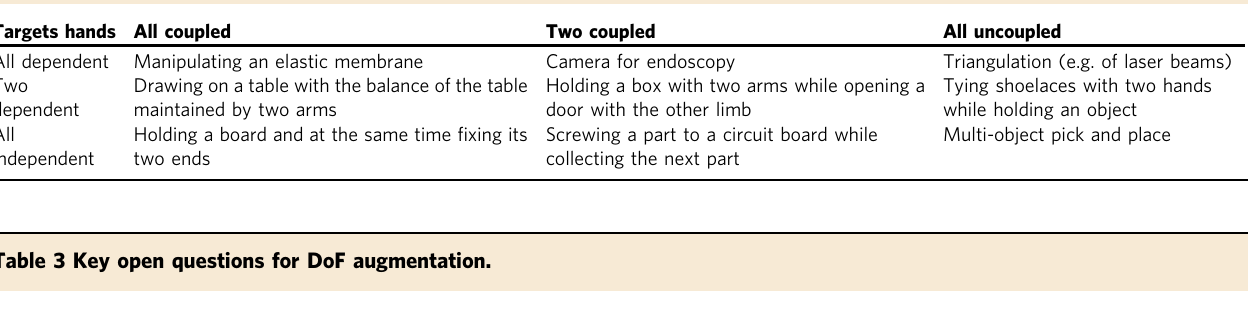
Table 2 Coordination types of one SE and two natural limbs with representative tasks. Representative types are arranged in a matrix where the rows denote the dependence of the task goals for each hand and the columns whether there is a coupling present.